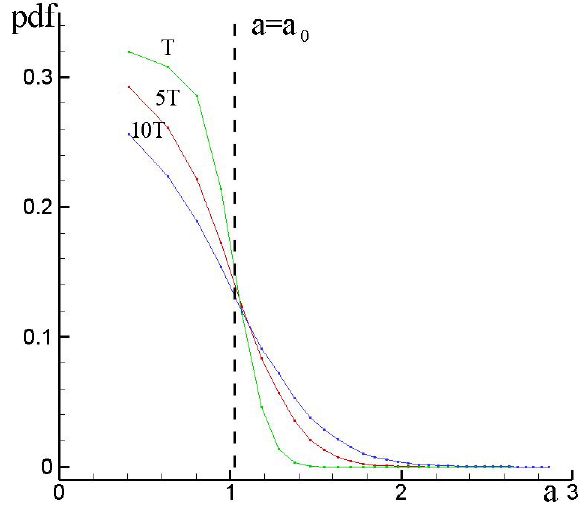
Fig. 4. Probability density as a function of the elliptic rings’ major semiaxis a in the steady state case. The curves depict the probability density at the instants corresponding to different number of the vor- tex rotation periods. Vertical dashed line marks the major semiaxis of the